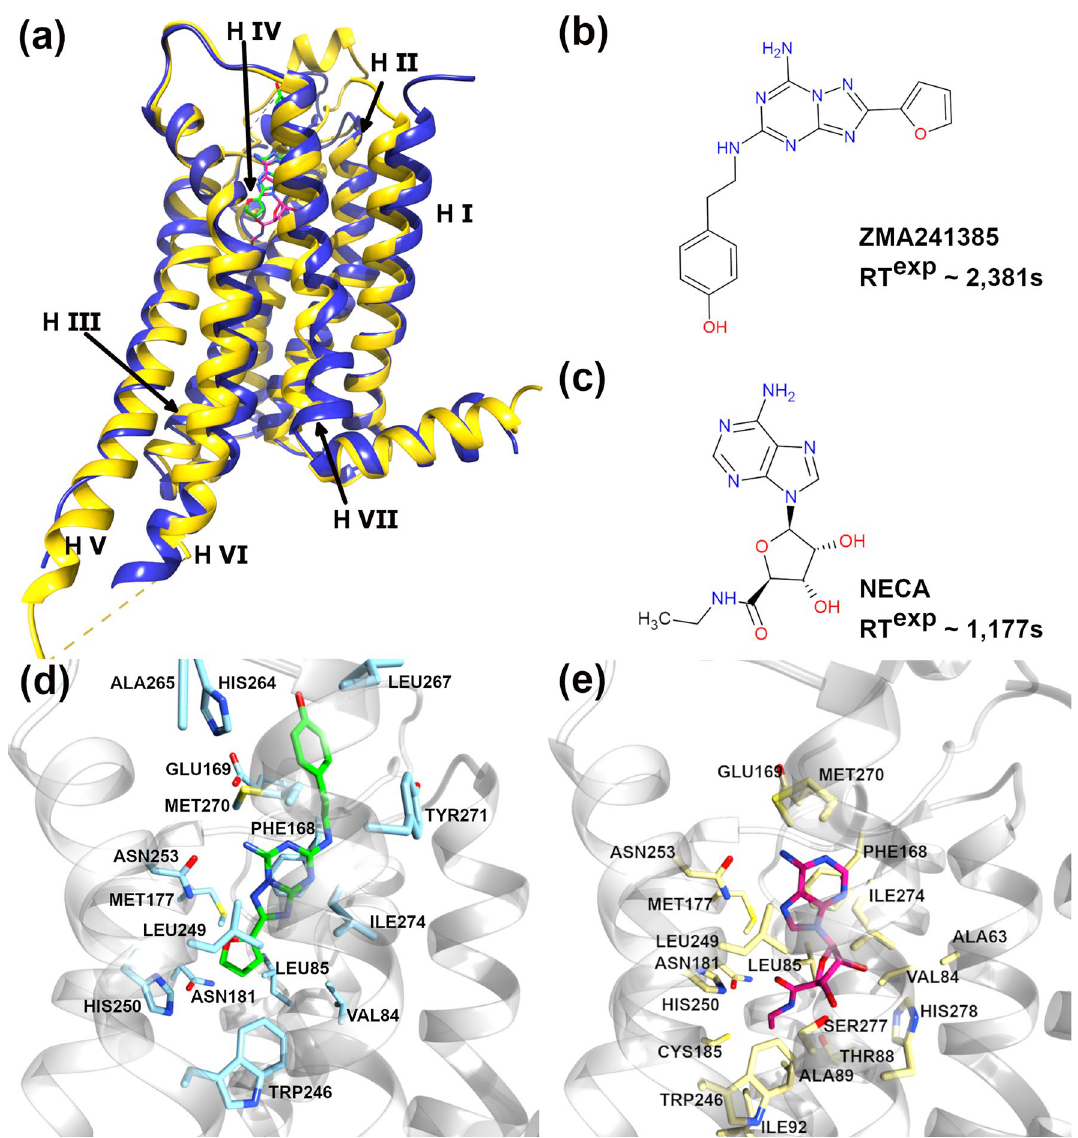
Figure 1. ( a ) The A2A AR-ligand complexes embedded into the 1-palmitoyl-2oleoyl-sn-glycero-3- phosphocholine (POPC) lipid bilayer; the A2A ARs corresponding to the PDB ids 3EML and 2YDV are shown in blue and yellow, respectively. The receptor helix (H) numbers are indicated in roman numbers. Experimentally determined RTs (RT exp ) of ligands ( b ) ZMA241385 (4-(2-[7-amino-2-(2-furyl)-[1,2,4] triazolo[2,3-a][1,3,5]triazin-5-ylamino]ethyl)-phenol) and ( c ) NECA (N-Ethyl-5’-Carboxyamido Adenosine) are indicated. The binding pocket residues of the A2A AR within 5 Å of the ligands ( d ) ZMA241385 (green) and ( e ) NECA (magenta) are shown in blue and yellow sticks,